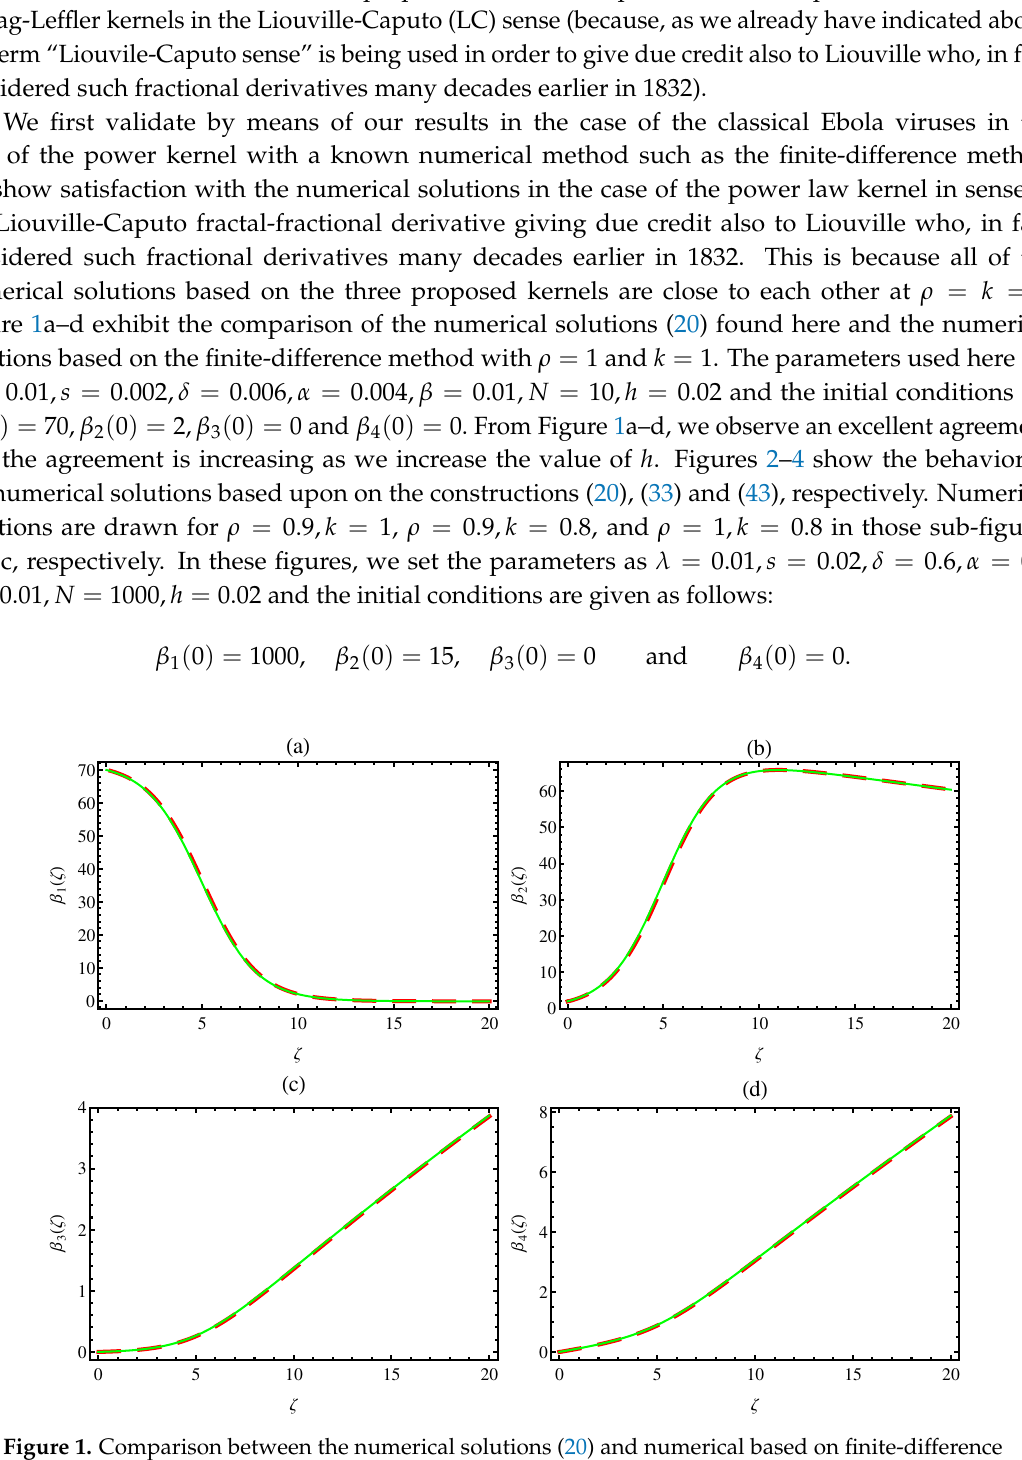
Figure 1. Comparison between the numerical solutions (20) and numerical based on finite-difference methods for ( a ) β 1 ( ζ ) , ( b ) β 2 ( ζ ) , ( c ) β 3 ( ζ ) and ( d ) β 4 ( ζ ) , respectively, with ρ = 1, k = 1, λ = 0.01, s = 0.002, δ = 0.006, α = 0.004, β = 0.01, N = 10, h = 0.02 and the following initial conditions: (cid:0) β 1 ( 0 ) = 70, β 2 ( 0 ) = 2, β 3 ( 0 ) = 0and β 4 ( 0 ) = 0. Green solid color: Numerical solutions based on (cid:1) finite-difference methods; Red dashed color: Numerical solutions (20)